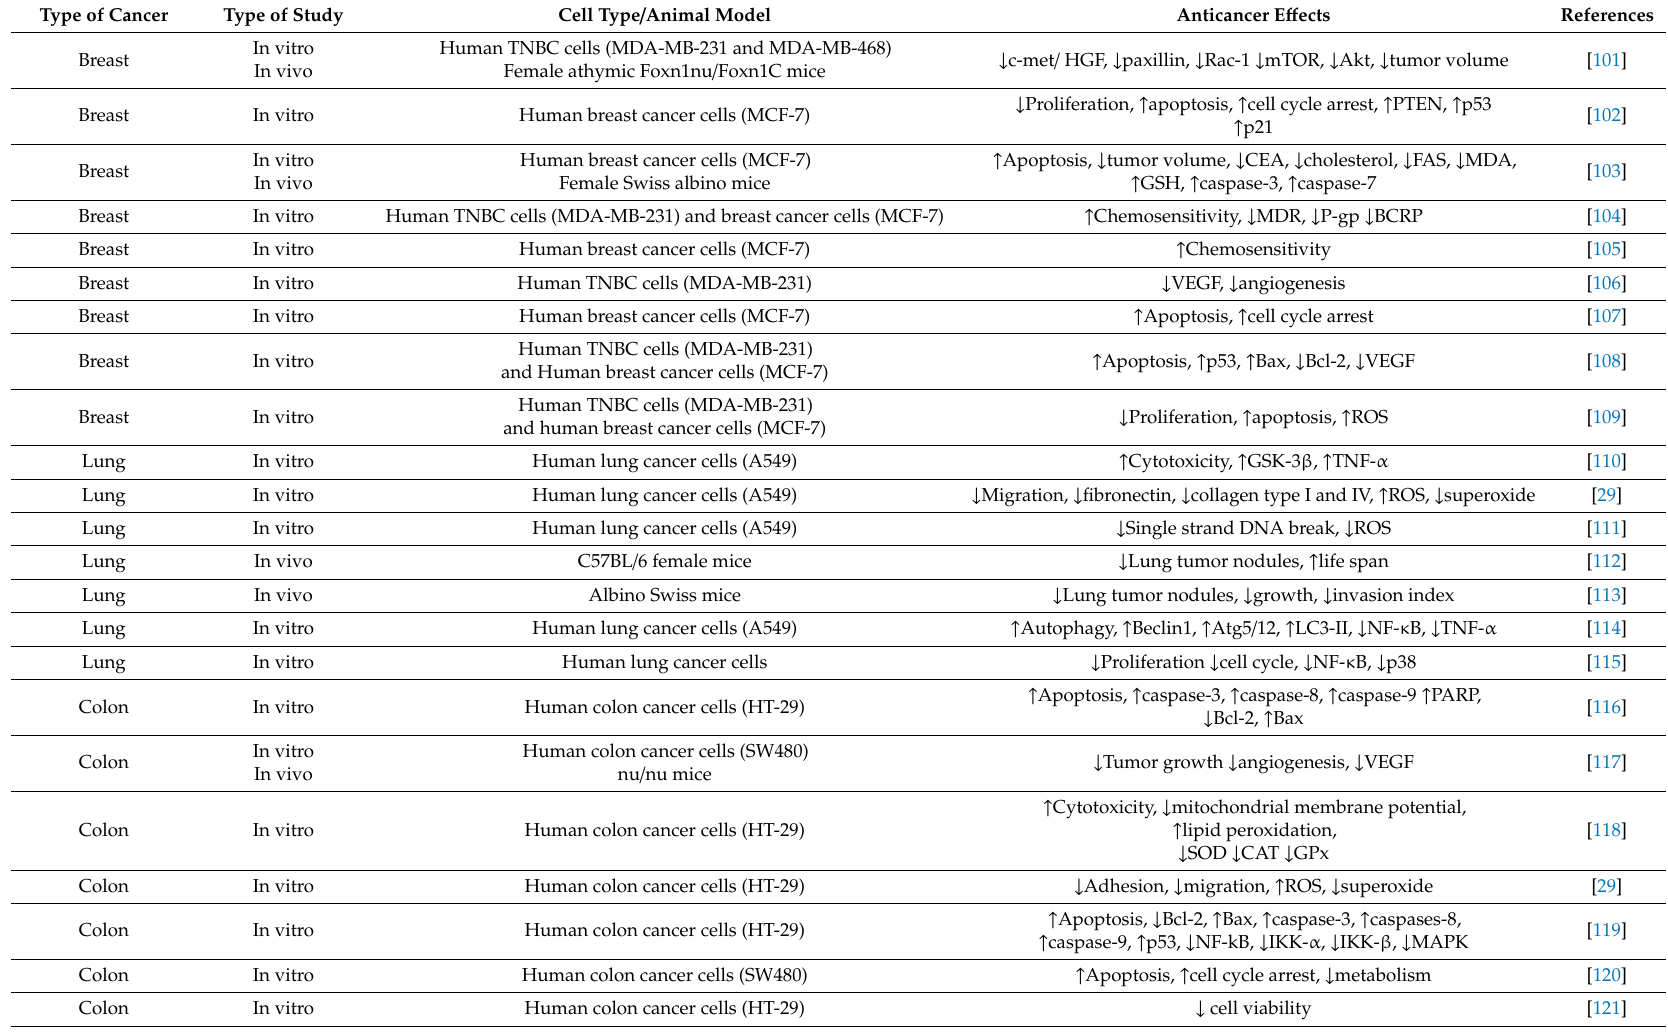
Table 1. Potential anticancer e ff ects and mechanisms of action of rutin based on in vitro and in vivo